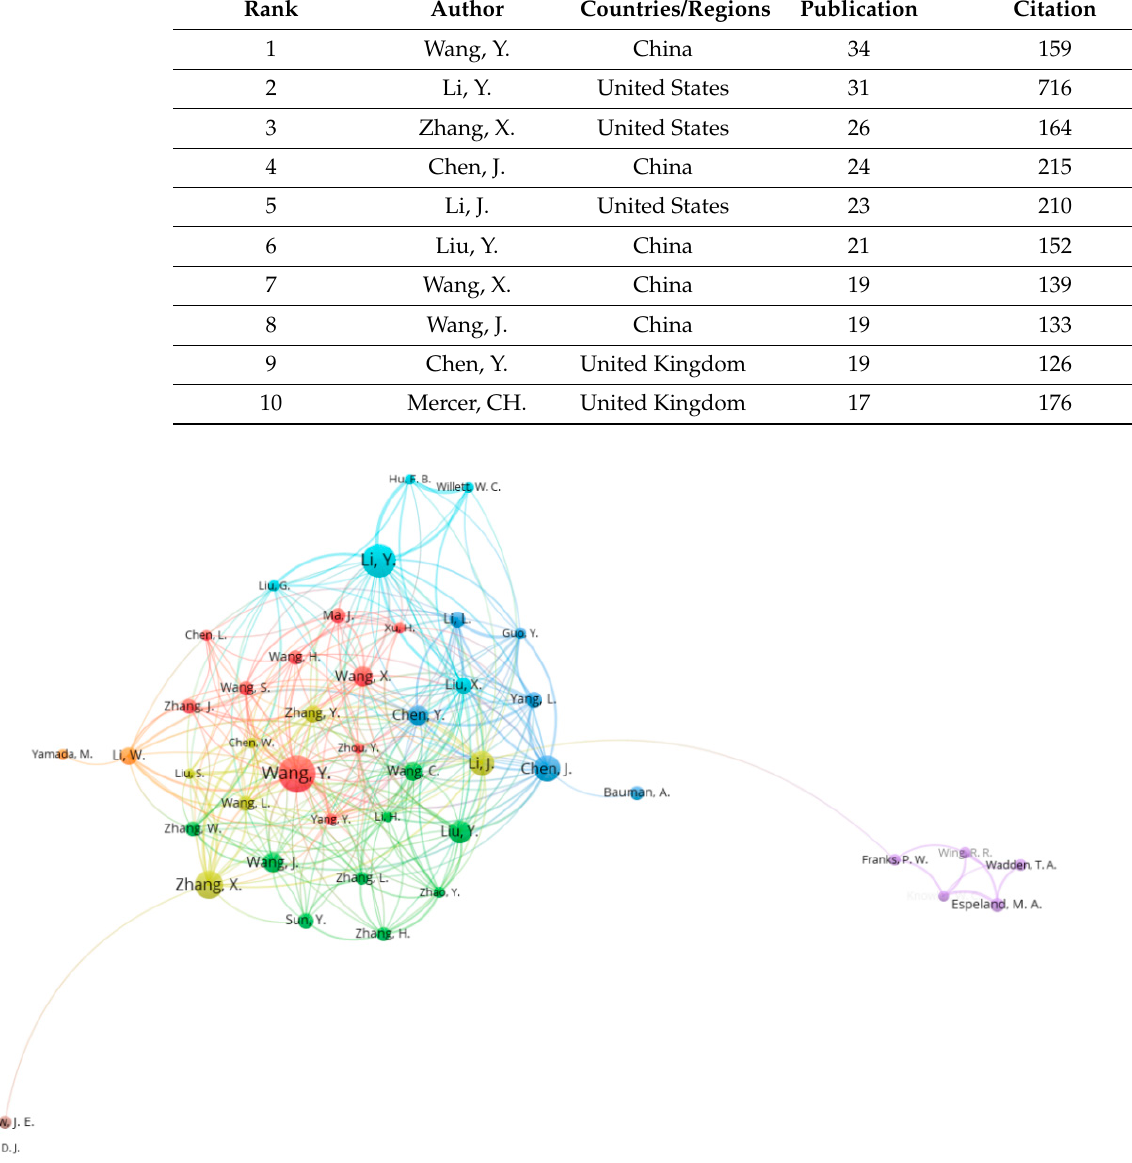
Table 4. Top 10 most productive authors in lifestyle research, 2016–2020.